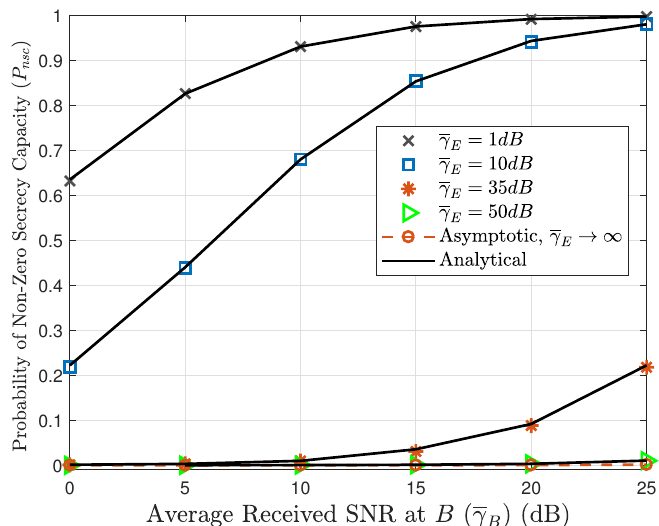
Figure 9. The probability of non-zero secrecy capacity ( P nsc ) for different values of the average received SNR at E ( ¯ γ E ) . For the main channel, κ = 2, µ = 2, and for the wiretap channel, κ e = 0, µ e = 1. N = 2, n e = 1, K = 1, α = 2, λ e = 0.1, and i =